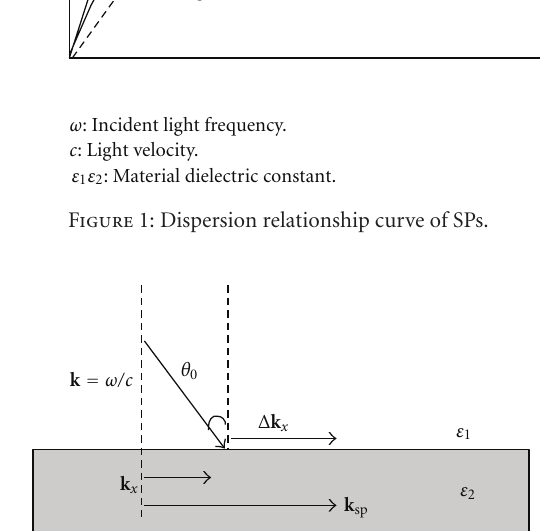
Figure 2: SPs excited by